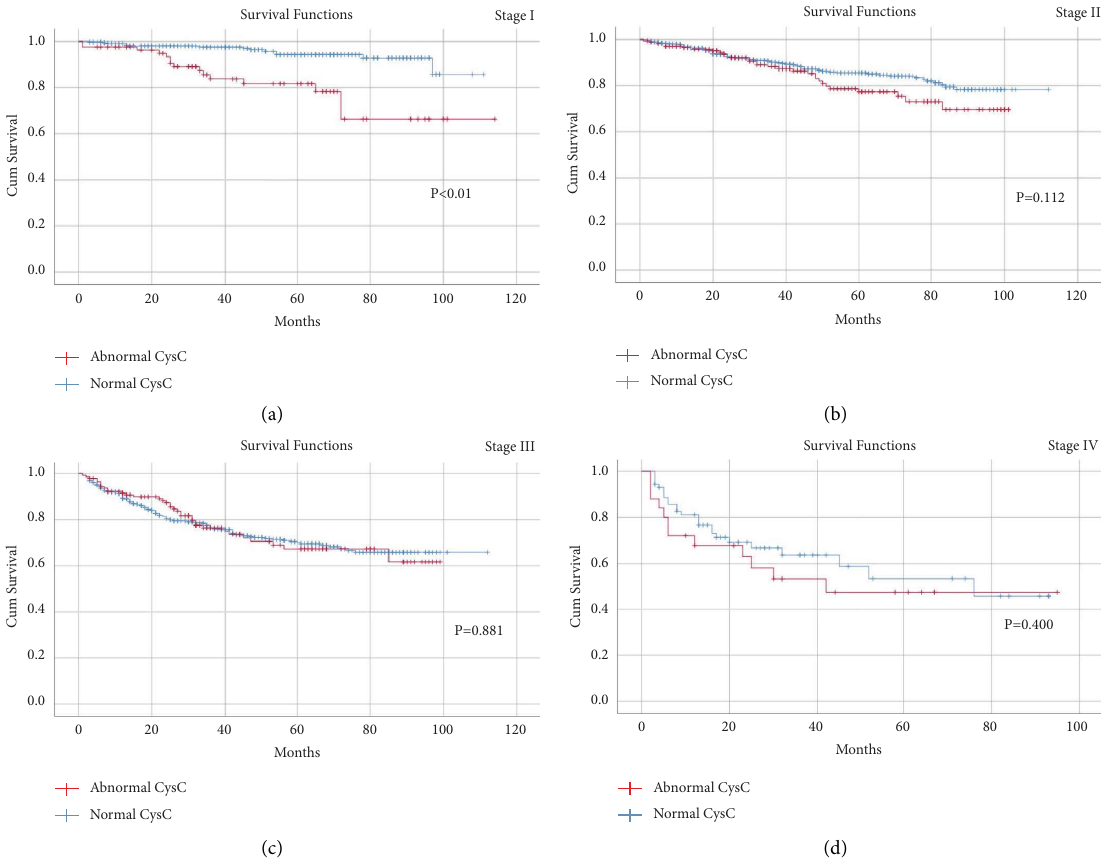
Figure 3: Kaplan − Meier survival curve for the impact of preoperative CysC on the disease-free survival of patients in TNM stages